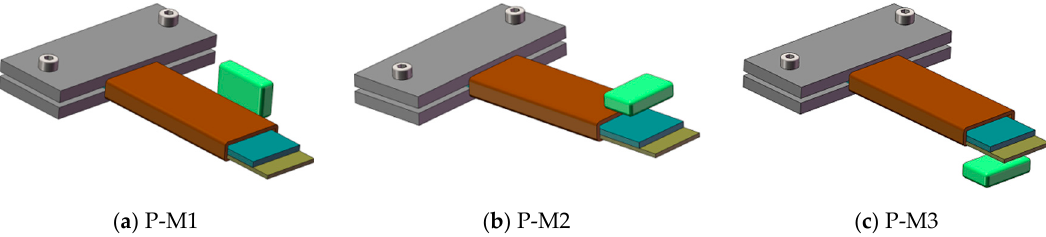
Figure 15. Position and layouts of the premagnetized magnet in the harvester. ( a ) magnet is on the right side of the beam (P-M1); ( b ) magnet is above the beam (P-M2); ( c ) magnet is arranged below the beam (P-M3).